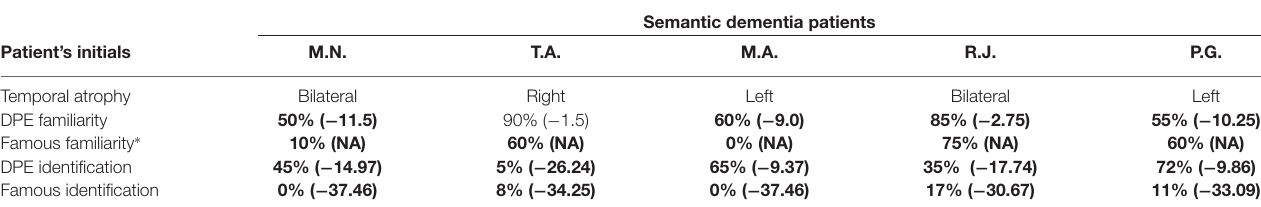
TABLE 2 | Percentage of correct responses (and Z scores) in both experimental conditions (personally familiar names vs. famous names) in performances of each semantic dementia patient on the familiarity judgment and identification free-recall task using a strict scoring system (see